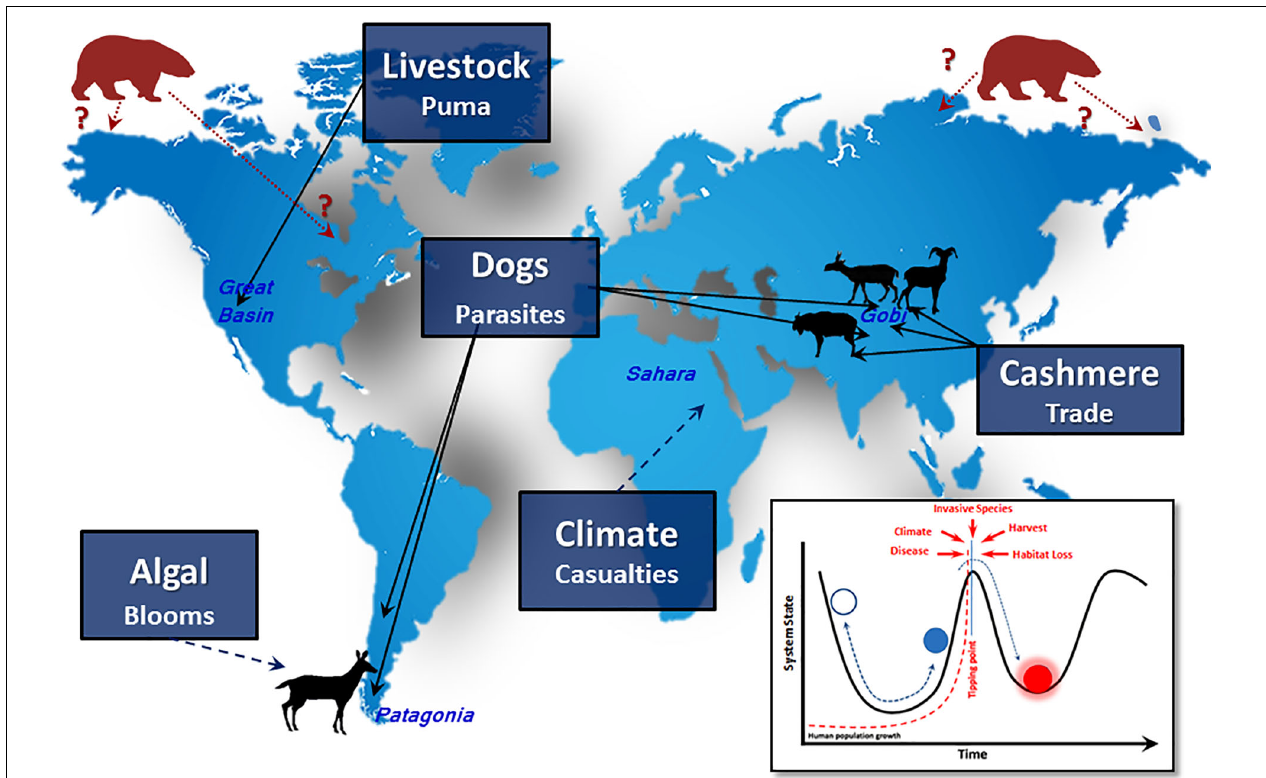
FIGURE 1 | Overview of locations, ungulates, and ecological disruptors. Species silhouettes are pointed out in the text. Inset–modification of Holling’s (1986) resiliency model with biotic and climate disruptors coupled with exponential human